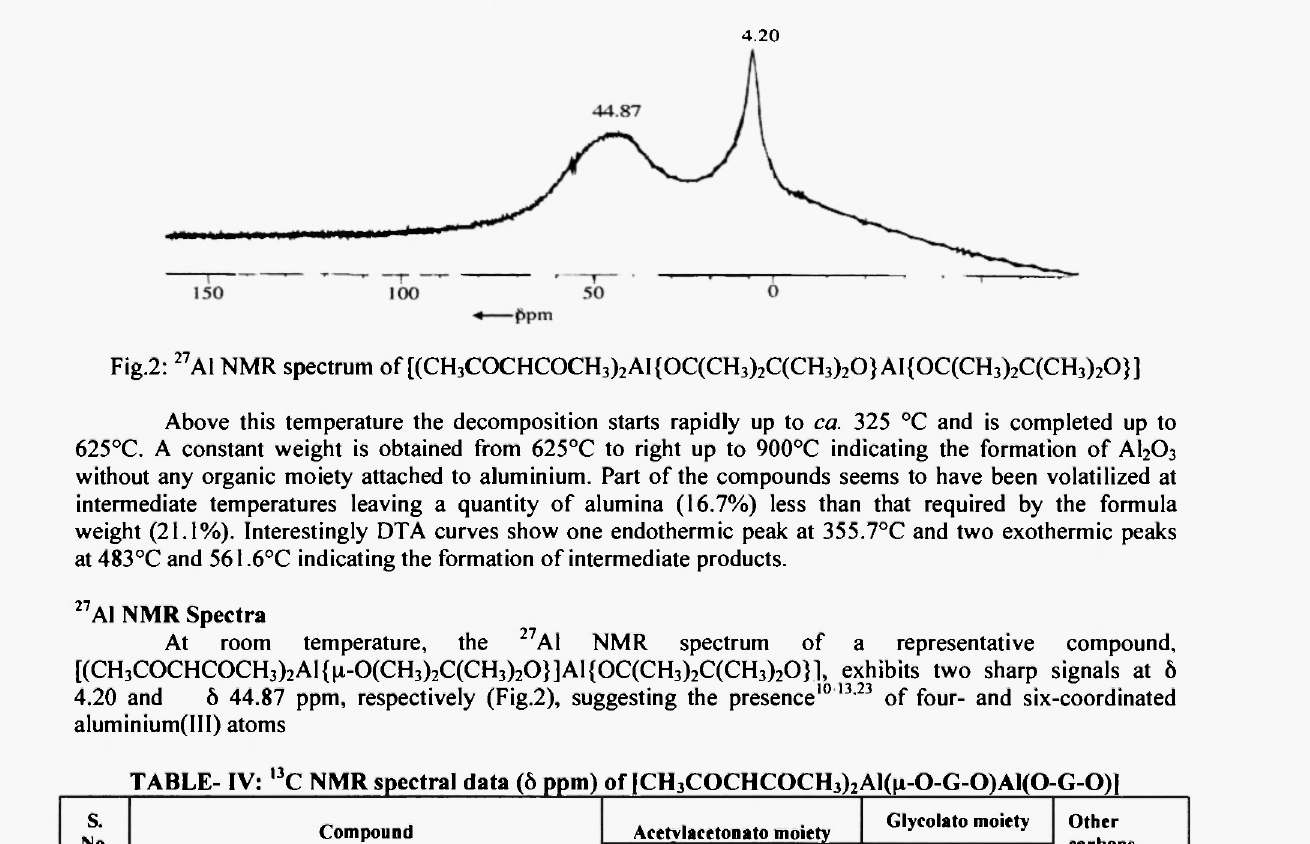
TABLE- IV: 13 C NMR spectral data (δ ppm) of |CH 3 C0CHC0CH3)2Al^-0-G-0)Al(0-G-0)| s.